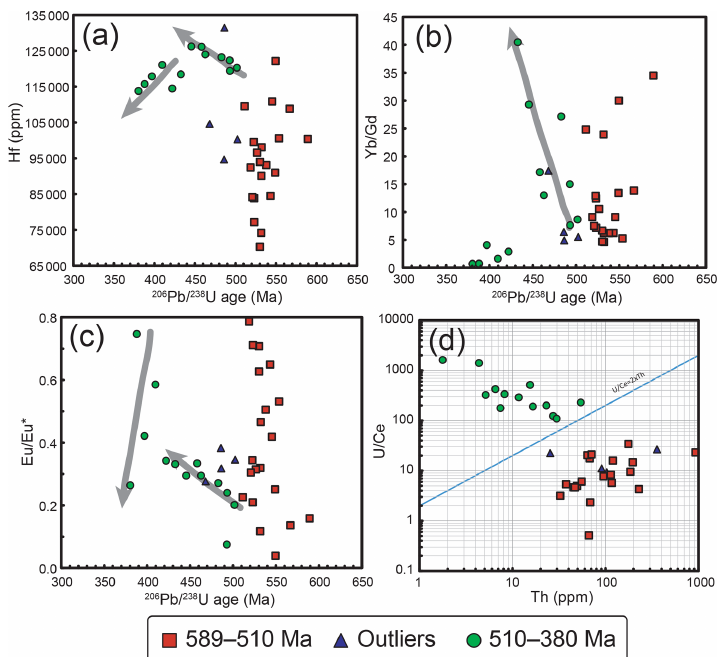
Figure 13. (a) Hafnium versus age, (b) Yb / Gd versus age, (c) Eu / Eu ∗ versus age and (d) U / Ce versus Th for zircon analyses between 589 and 380Ma.